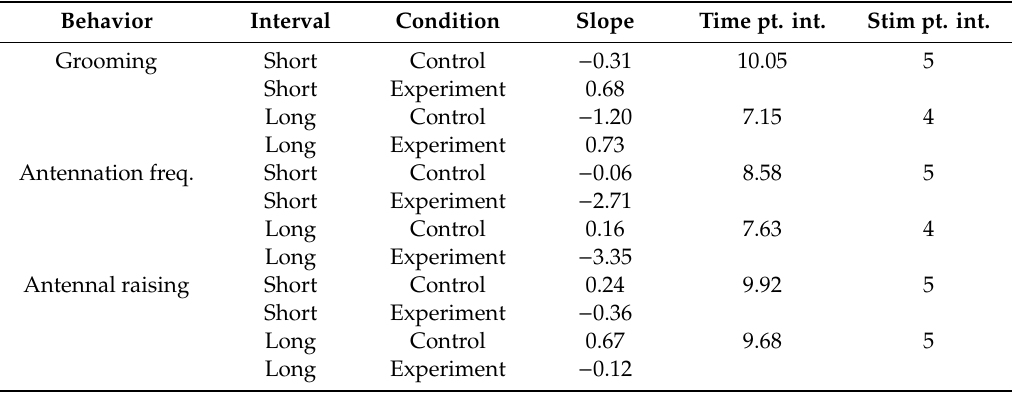
Table 2. Points at which alarmed ant behavior returns to resting ant behavior. “Time pt. int.” refers to the x axis value where Control and Experiment linear models (shown on Figure 4) intercept. “Stim pt. int” refers to the nearest stim point that the linear model intercepts round up